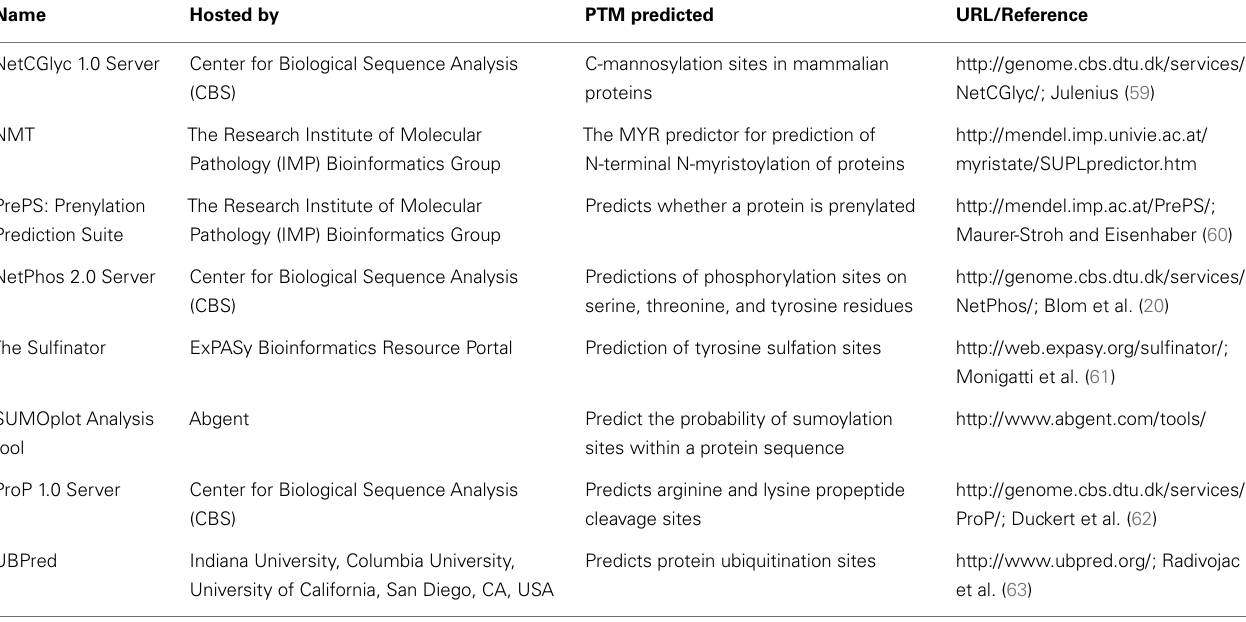
Table 2 |A representative collection of bioinformatic tools for post-translational modification (PTM) prediction